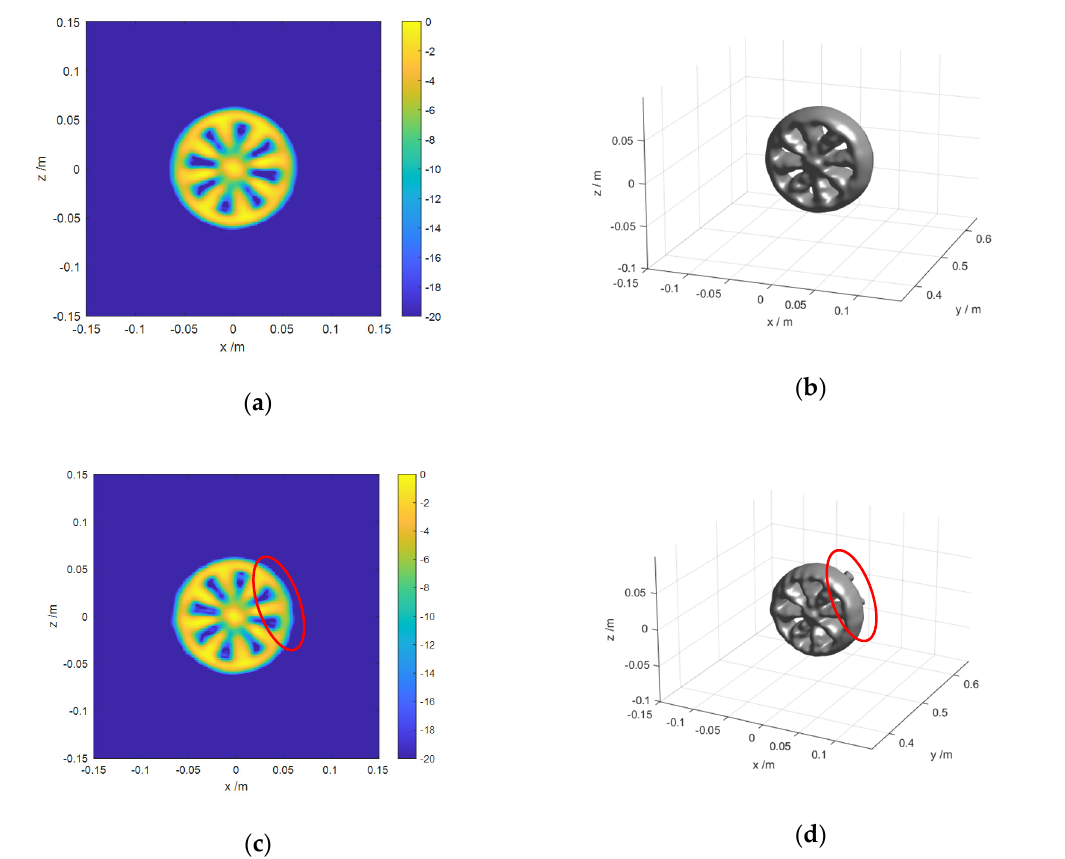
Figure 10. Imaging results of different algorithms for ARRAY A: ( a ) and ( b ) are the imaging result of the proposed algorithm; ( c ) and ( b ) are the imaging result of Enhanced algorithm.